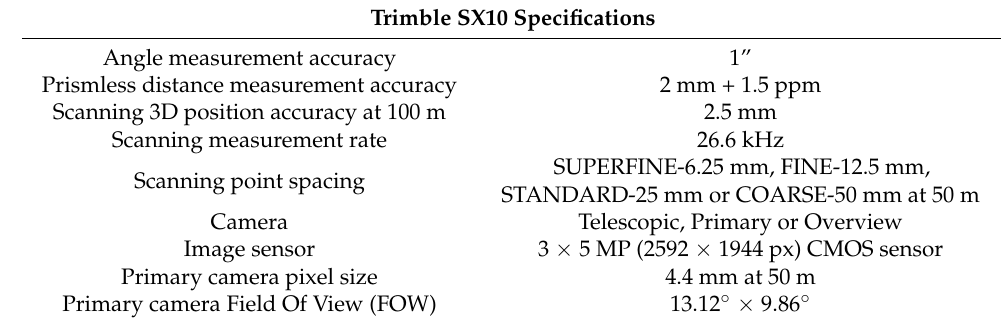
Figure 1. Trimble multi station SX10 (Source: Own compilation). Table 1. Trimble SX10 specifications [18] .